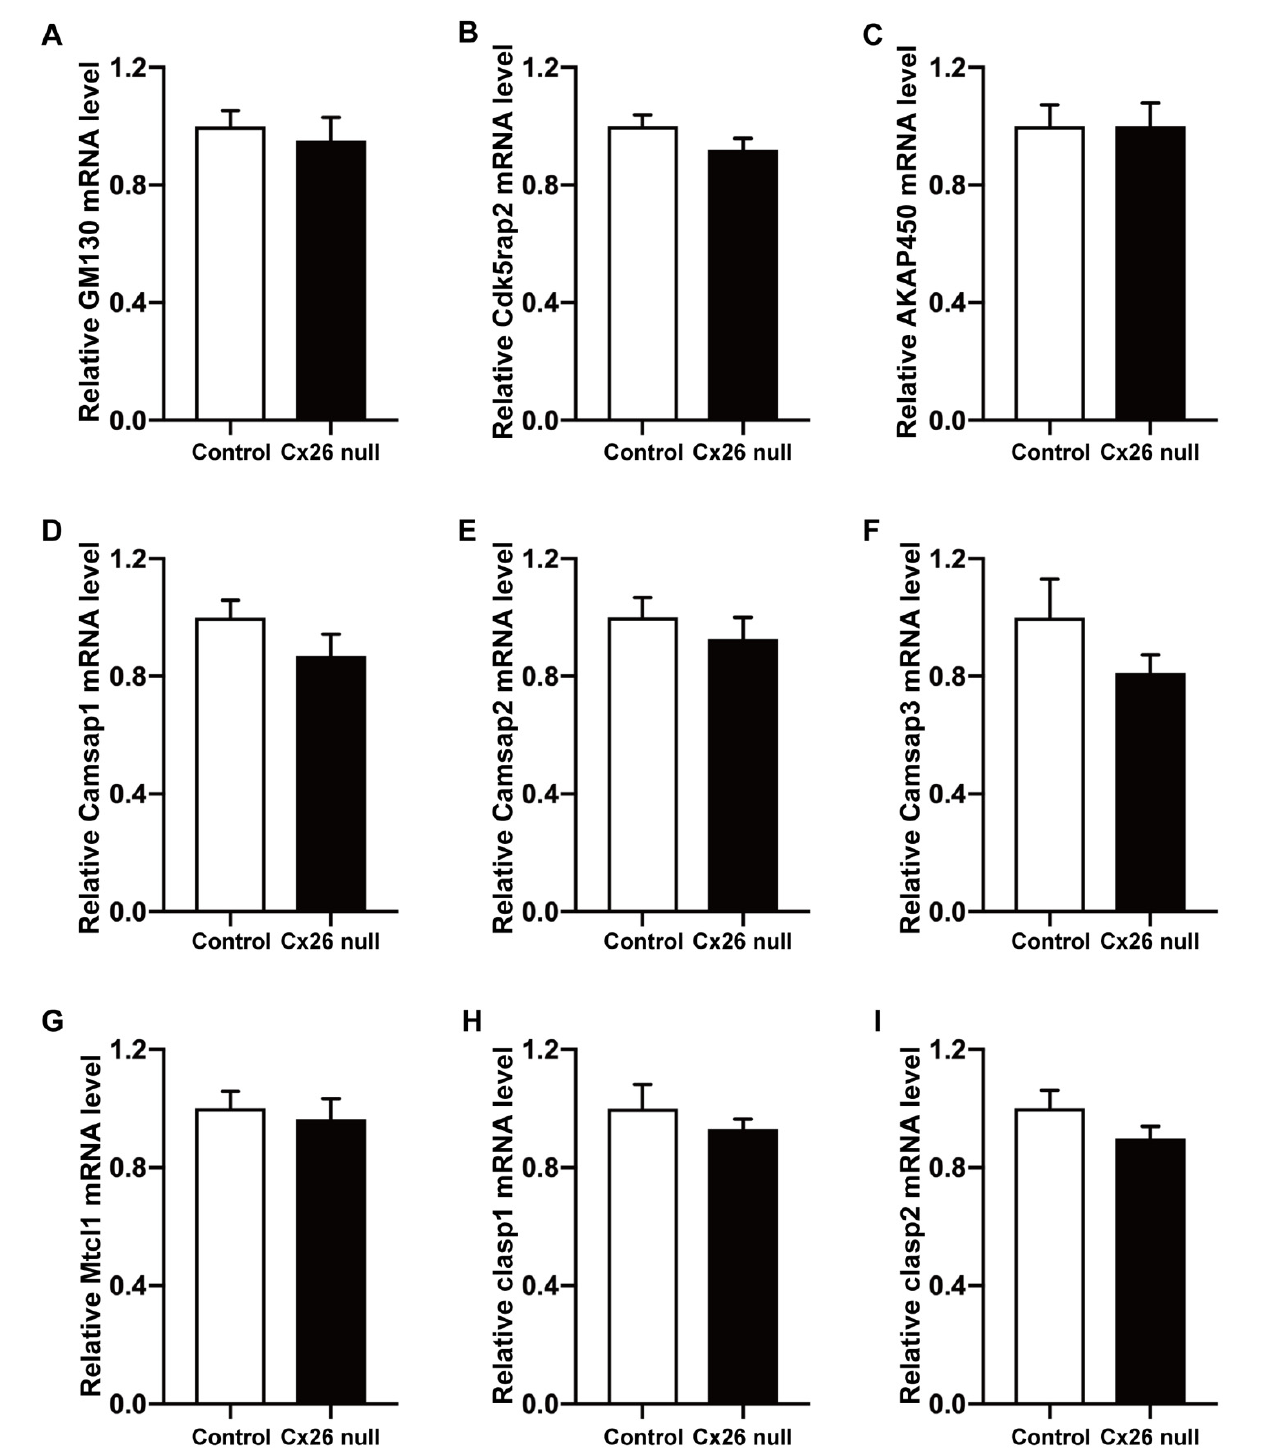
Figure 6. No changes were found in the mRNA expression levels of non-centrosomal MT nucleation- and anchorage-associated proteins. ( A – I ) The mRNA expression levels of GM130, Cdk5rap2, AKAP450, Camsap1, Camsap2, Camsap3, Mtcl1, Clasp1, and Clasp2 in the cochlear basilar membrane at P6. There was no significant difference between the control and Cx26-null groups (6 mice in each group, p > 0.05).